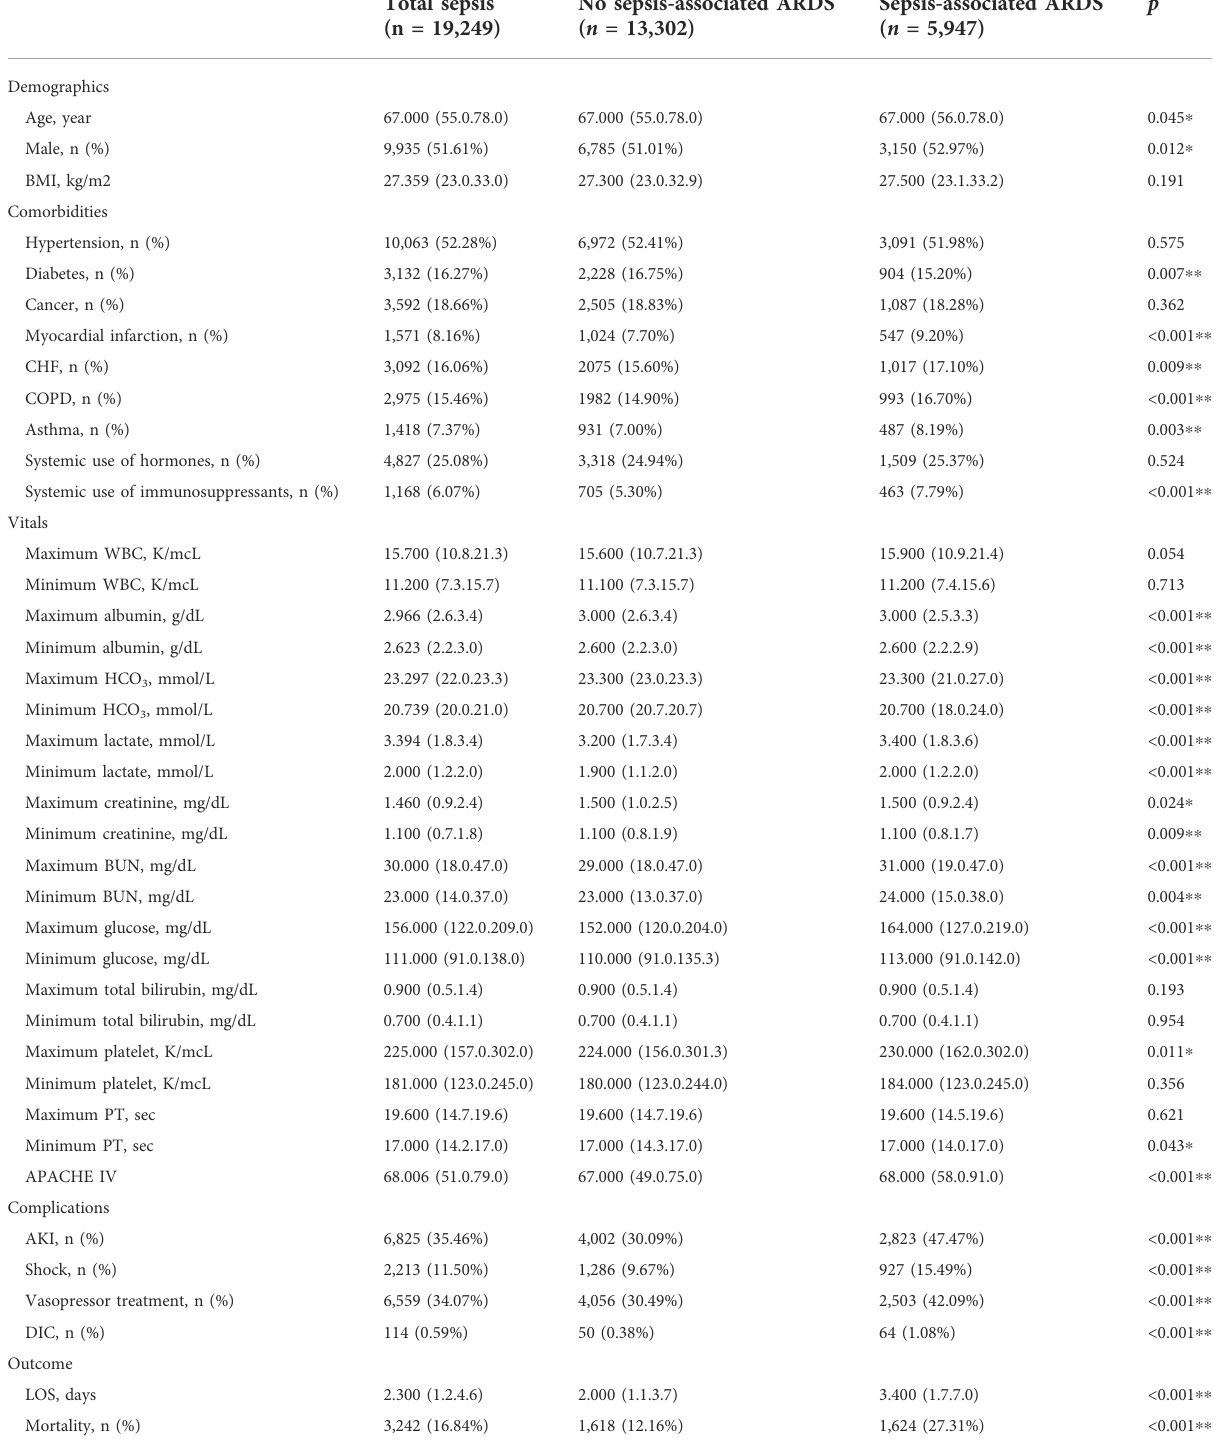
TABLE 1 Baseline demographic and clinical characteristics of patients from the eICU